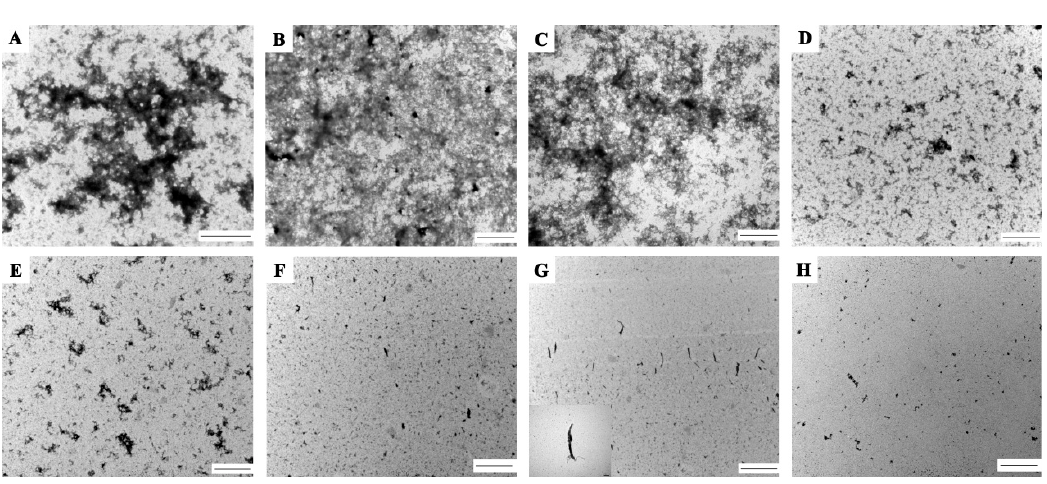
Figure 8. Representative Transmission Electron Microscopy (TEM) micrographs at 6000 × of EWP and SEWP aggregates: A (control), B (2.70%), C (5.83%), D (10.76%), E (37.63%), F (66.57%), G (72.37%), and H (73.84%). All the samples were analyzed by TEM after heat treatment at 90 °C or 30 min. The scale bars represent 1 μ m.